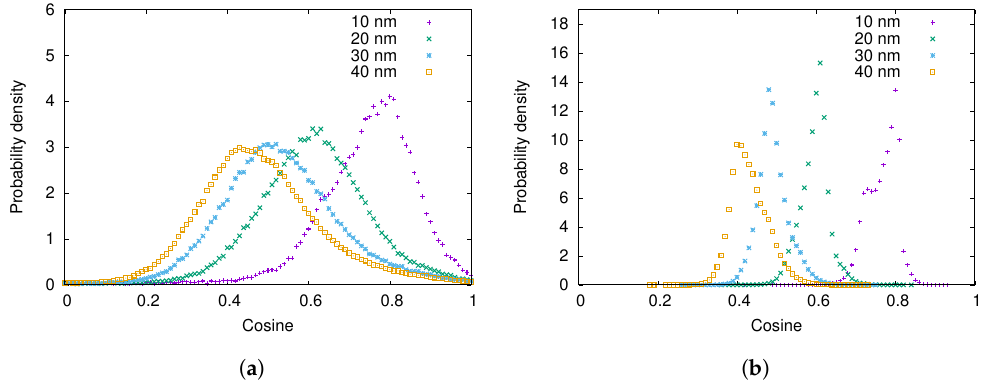
Figure 6. The distribution of cosine of the angle between the surface normal and the adsorbed fibrinogen main body for different nanoparticle radii when the surface charge density is: ( a ) − 0.001 e /Å 2 ; and ( b ) − 0.005 e /Å 2 .